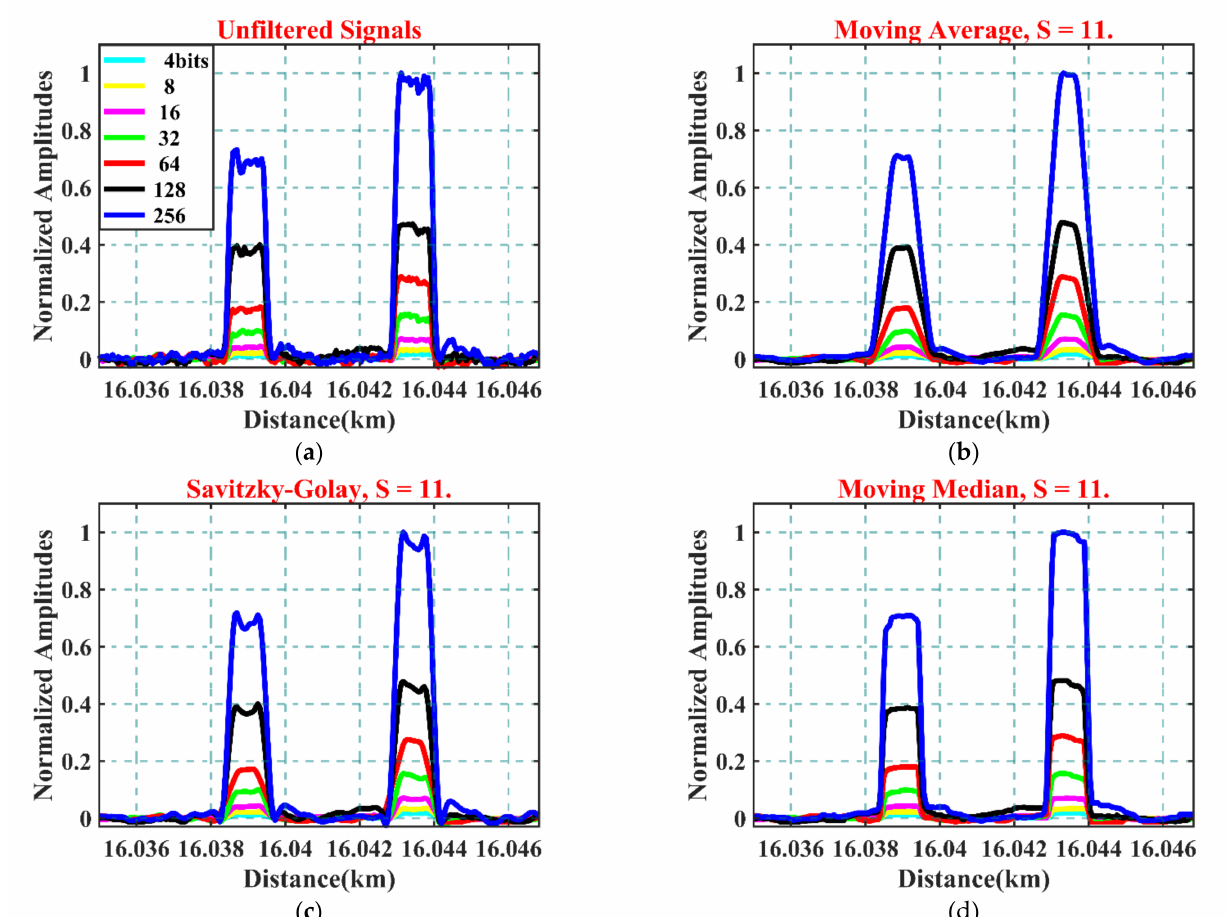
Figure 3. ( a ) FBG signal response to multiple Golay codelengths without filtering; ( b ) with MA, S = 11; ( c ) with SG, S = 11; ( d ) with MM, S =